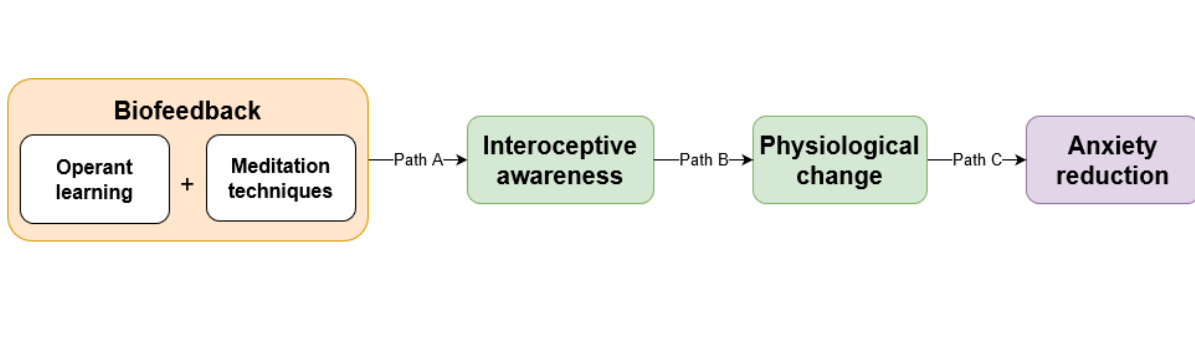
Figure 1. Traditional techniques and mechanisms thought to explain the effectiveness of biofeedback